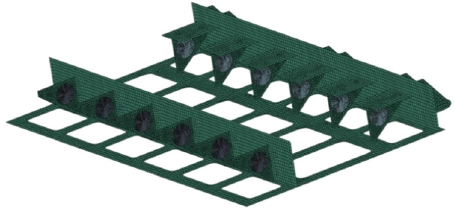
Figure 18: Raft model embedded with two - dimensional acoustic black